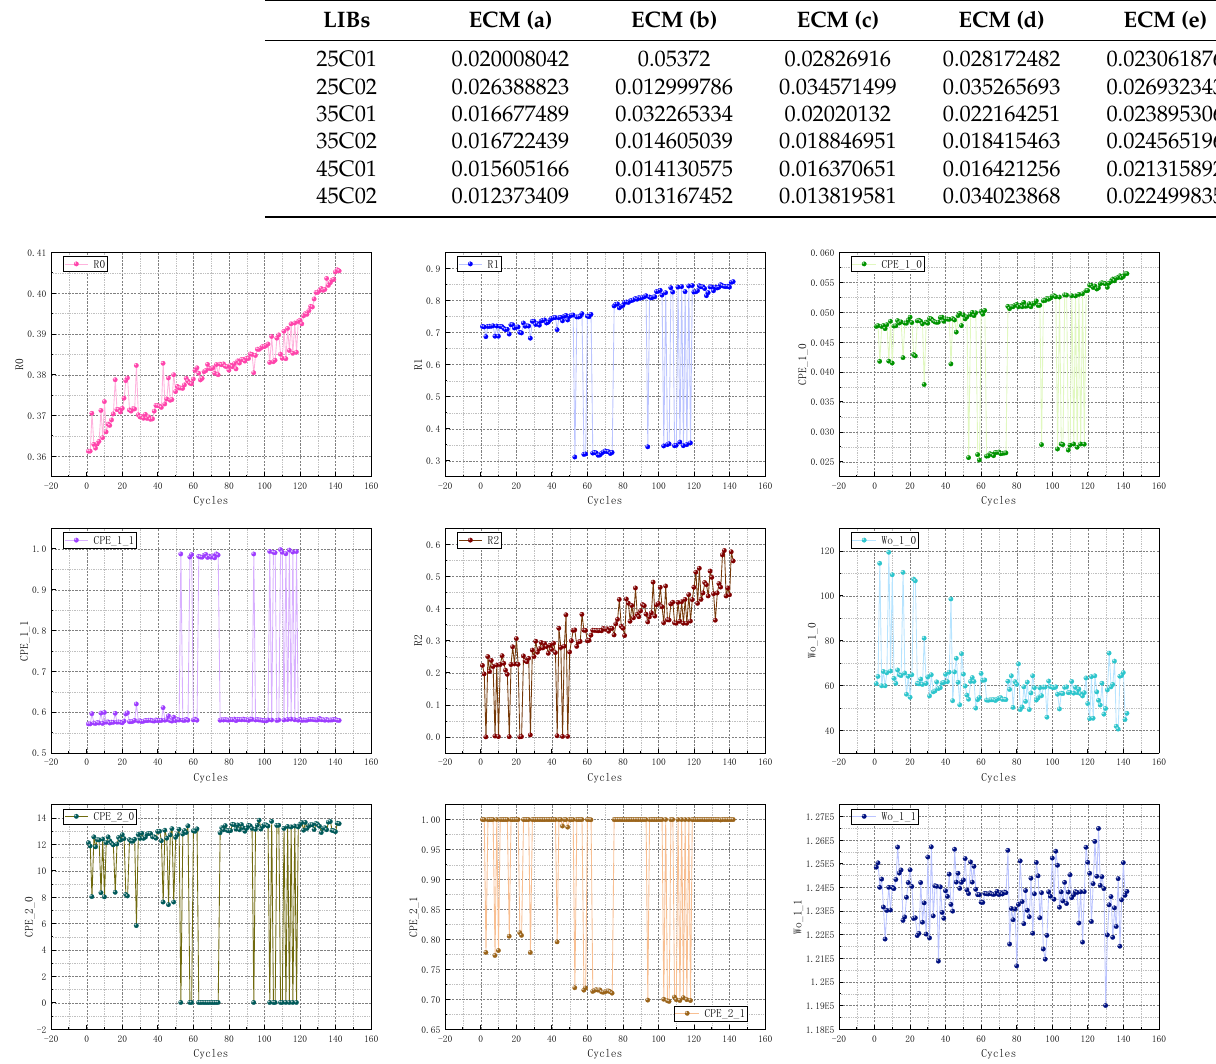
Figure 6. Curves of different parameters as the number of cycles increases. Table 4. The root mean square error (RMSE) of LIBs under different ECMs.